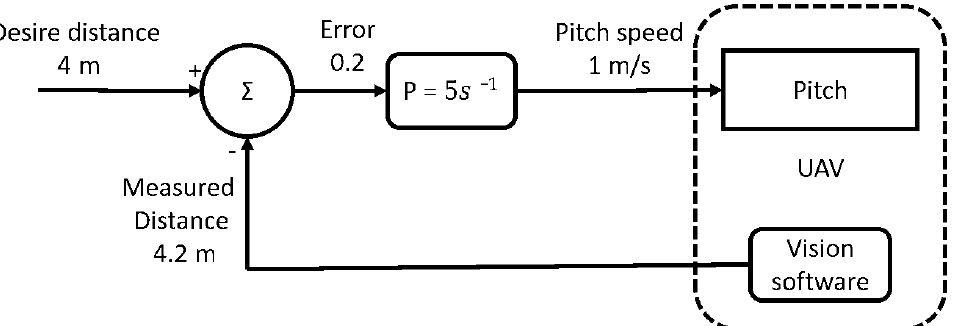
Figure 3. A proportional control loop. The error between a desired and measured value is calculated and multiplied with a scale factor to generate a control